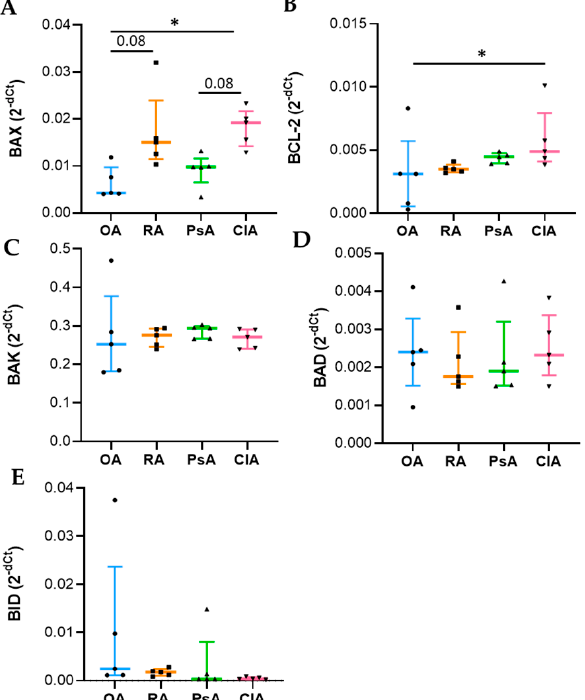
Figure 4. Apoptotic gene expression in SF from OA, RA, PsA, and CIA patients. Measurement of BAX ( A ), BCL-2 ( B ), BAK ( C ), BAD ( D ), and BID ( E ) gene expression was performed in selected SF